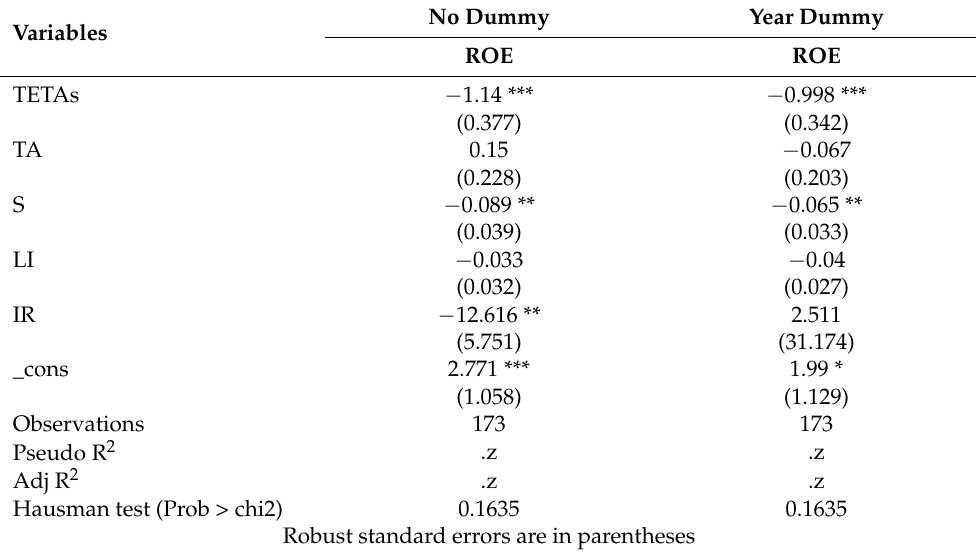
Table 21. Results of the Random Effects of TETAs on ROE, as per Panel Data Regression (Profit- Making